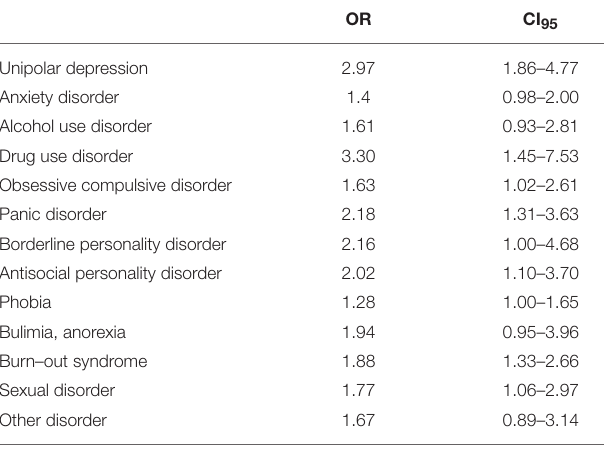
TABLE 7 | Association between mental health disorders and cat